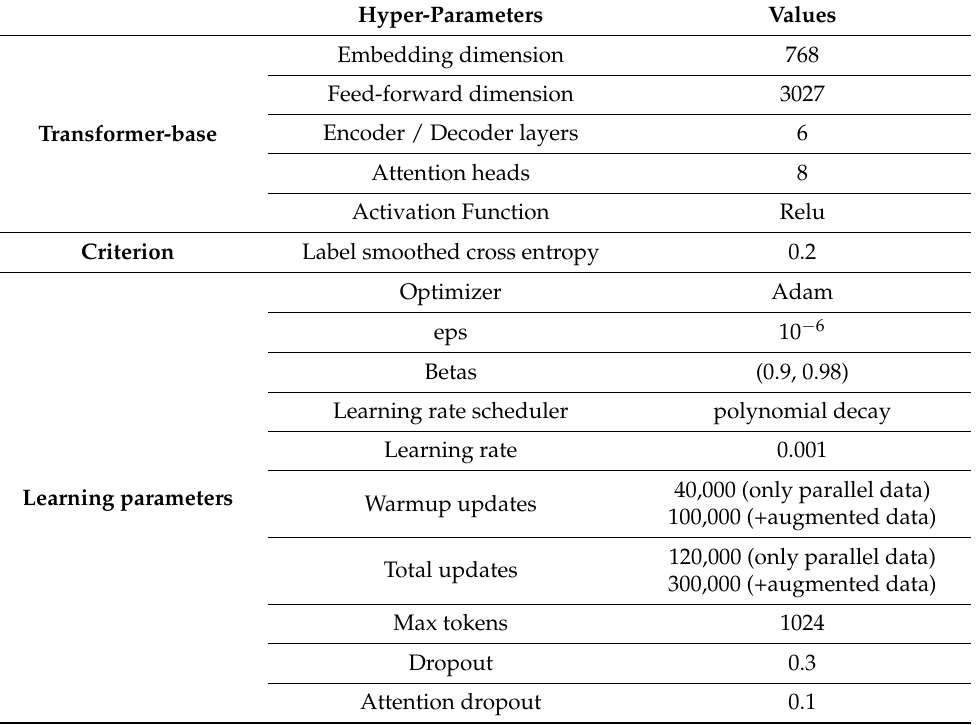
Table 2. Hyper-parameters of the NMT systems.